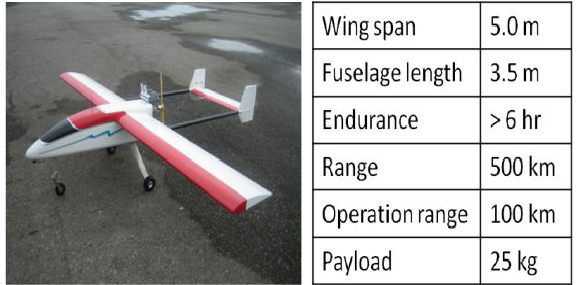
Figure 1. Proposed UAV platform